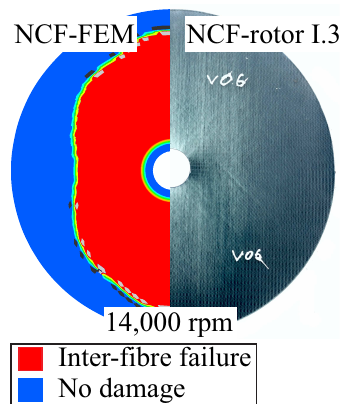
Figure 10. Numerically and experimentally determined inter-fibre failure for an in-plane load of 14,000